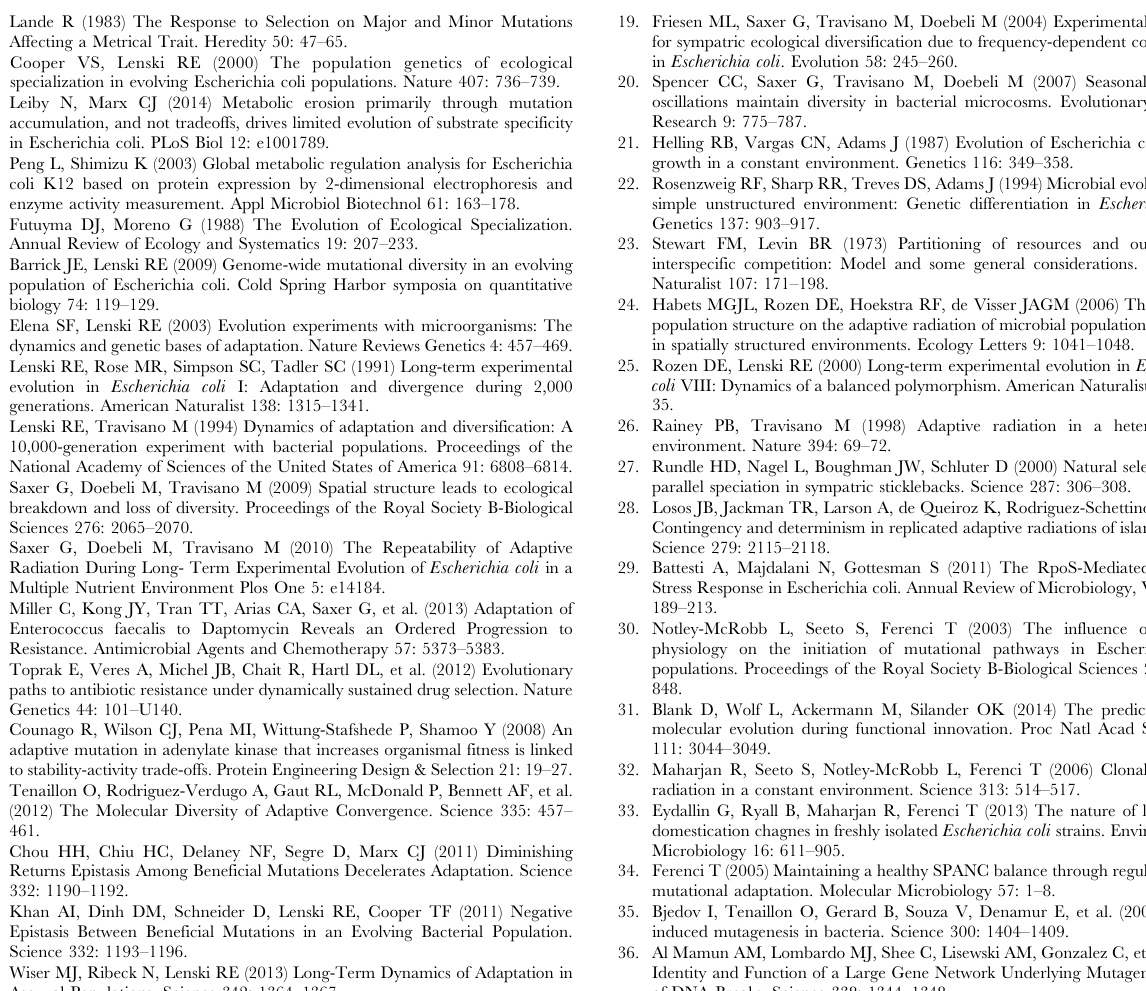
S1 Table Phenotypic changes in lag time, growth rate, stationary phase density and pH of spent media over the course of the selection experiment. The F and p-values are based on planned comparisons in a single factor ANOVA comparing the ancestor to the evolved populations, which were assayed as whole, polymorphic populations. S2 Table Proteins that changed significantly over the course of adaptation. The table lists the log2 changes from the average of the ancestor for three replicates for the ancestor and all the evolved populations for every protein that changed significantly. The proteins are annotated into functional classes. The heat map in Fig. 8 is based of a select functional classes. S3 Table Estimated media composition based on information provided in BD Diagnostics in Difco & BBL Manual – of Microbiological Culture Media and in BD Bionutrients Technical Manual – Advance Bioprocessing. The composition of individual media components (e.g. tryptone) were listed for the individual components of the media (e.g. tryptone) as % of the dry weight (e.g. total glutamic acid in tryptone is 15%). To estimate the final concentration of the different amino acids in the media, we calculated the content in each component (e.g. tryptone)